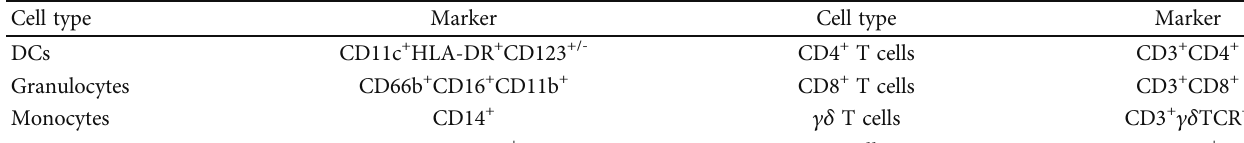
Table 2: Cell classi fi